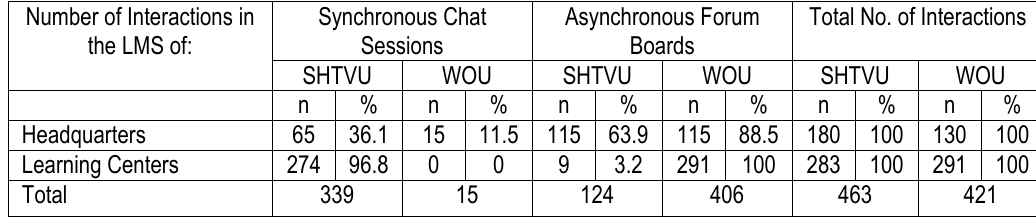
Table 9. Number of Students Participated in the Chat Sessions and Forum Boards of SHTVU and WOU Synchronous Chat Asynchronous Forum No. of Students Total Students Enrolled Number of Sessions Boards Participated Participants in the LMS SHTVU WOU SHTVU WOU SHTVU WOU SHTVU WOU of : Head- 43 3.0 23 6.4 86 5.9 80 22.2 121 8.3 93 25.8 1451 100 361 100 quarters Learning 84 35.9 0 8 3.4 71 19.7 36.8 19.7 234 100 361 100 Centers Table 10. Number of Interactions in the Chat Sessions and Forum Boards of SHTVU and WOU Synchronous Chat Asynchronous Forum Total No. of Interactions Number of Interactions in Sessions Boards the LMS of: SHTVU WOU SHTVU WOU SHTVU WOU % Headquarters 65 36.1 15 11.5 115 63.9 115 88.5 180 100 130 100 Learning Centers 274 96.8 0 0 9 3.2 291 100 283 100 291 100 Total 339 15 124 406 463